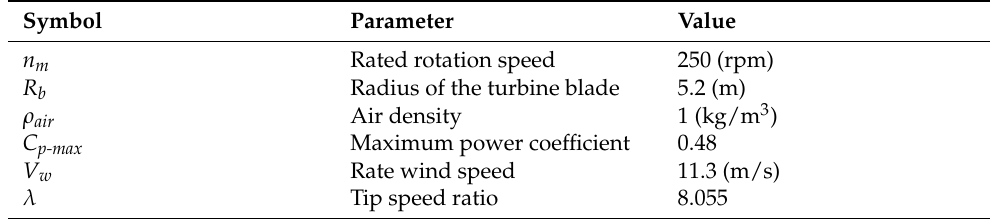
Table 1. The specifications of the wind turbine.